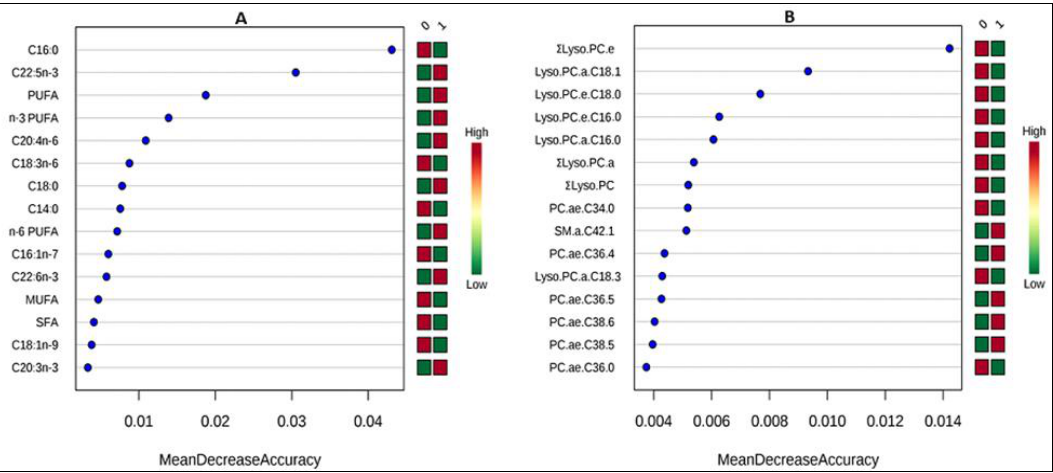
Figure 2. Significant metabolites: ( A ) total glycerophospholipid fatty acids ( B ) phospholipid species identified by random forest. The metabolites are ranked by the mean decrease in classification accuracy when they are permuted. Red and green squares indicate high and low levels of the metabolites, respectively. “0” and “1” refer to the two time points investigated in the study (t0 or baseline and t1 (after treatment with RUTF).